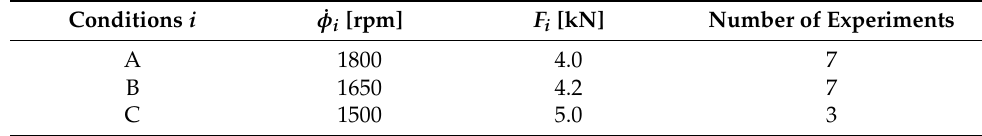
Table 1. Available experiments and loading conditions.